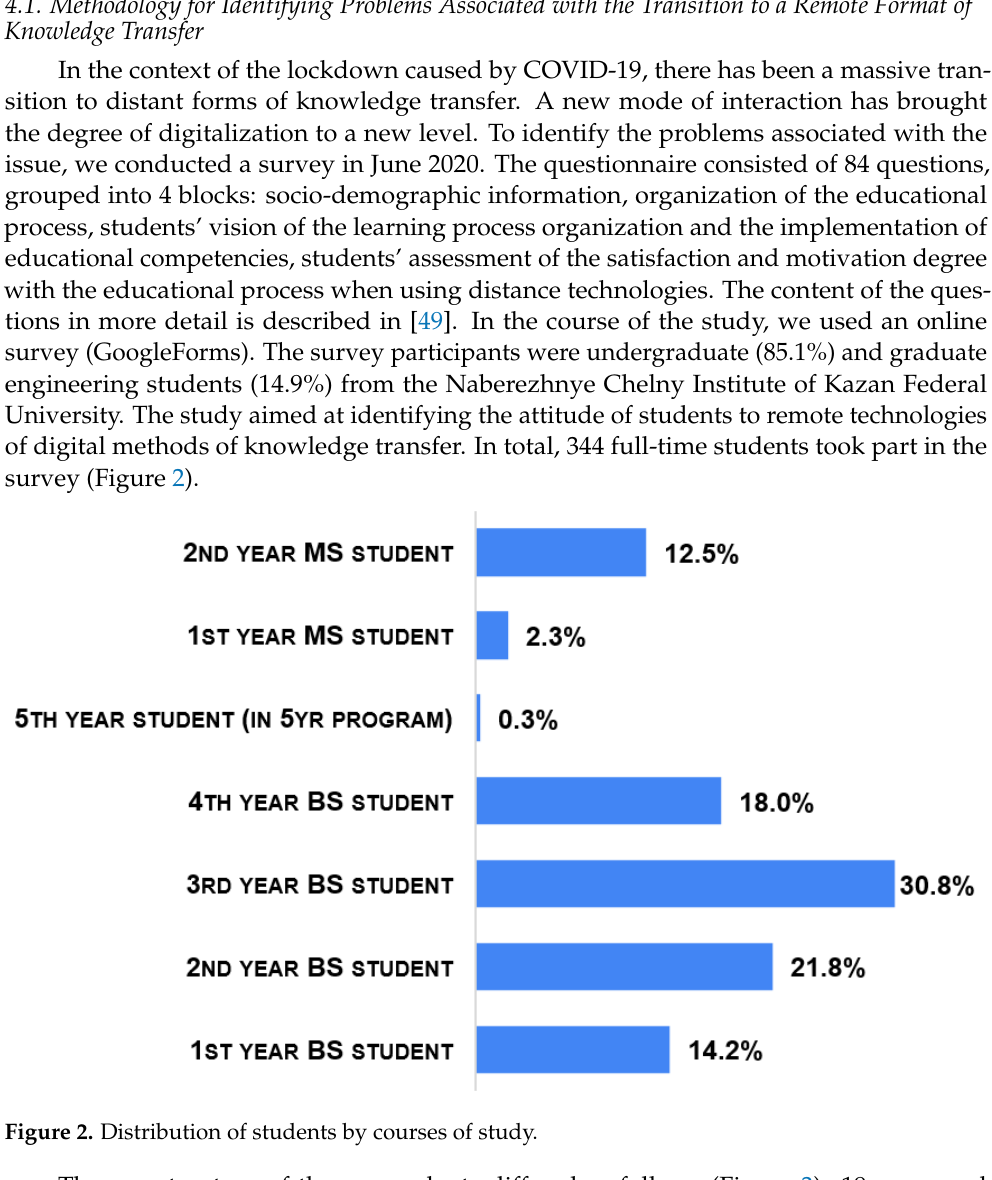
Figure 3. Age composition of the students. We also analyzed the results of the examination session of these students. 4.2. VR Lab: Target Audience, Duration, Learning Process, and Activities To overcome the limitations associated with the remote form of transferring practical knowledge, a virtual laboratory was developed at the Naberezhnye Chelny branch of